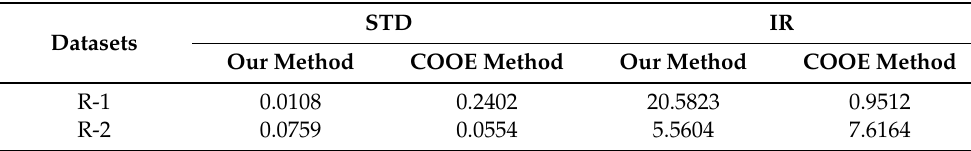
Table 6. Comparisons of repair results between the proposed method and the COOE method on real